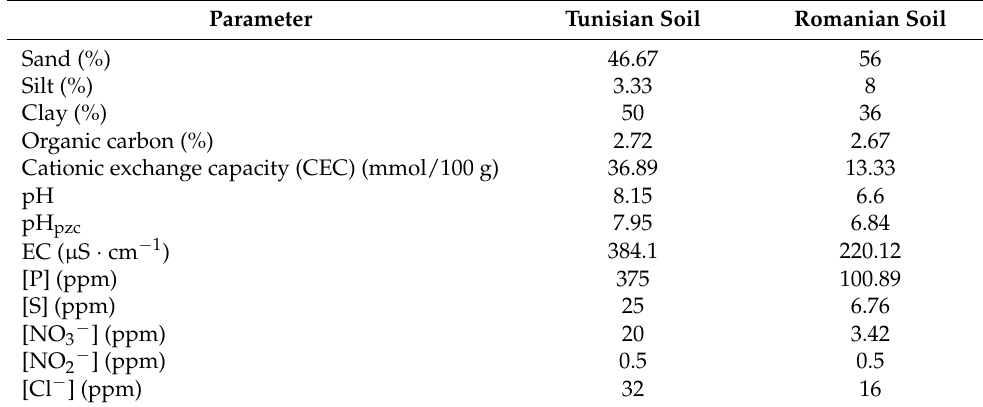
Table 1. Main properties of Tunisian and Romanian soils.